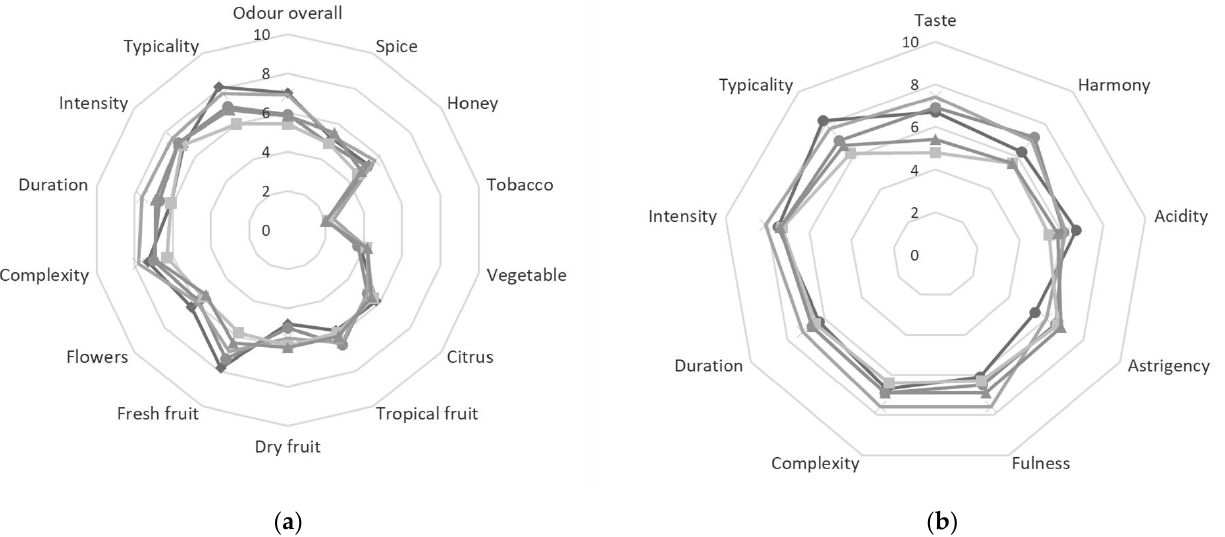
Figure 2. Sensory analysis of ( a ) smell and ( b ) taste profile of wines produced with maceration and fermented with C. famata WB-1 ( ■ ), C. famata WB-1 + S. cerevisiae QA23 ( ▲ ), M. pulcherrima B- 5 (●), M. pulcherrima B-5 + S. cerevisiae QA23 (x) and S. cerevisiae QA23 ( ♦ ) .